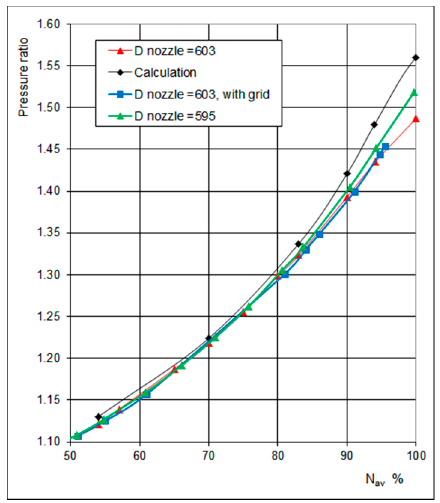
Figure 18. Total pressure ratio as a function of average rotational speed ( N av ).